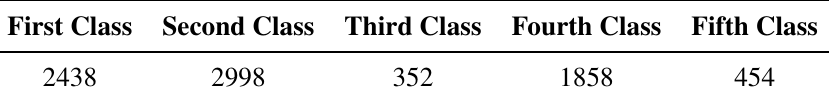
Table 4. Number of patches in each